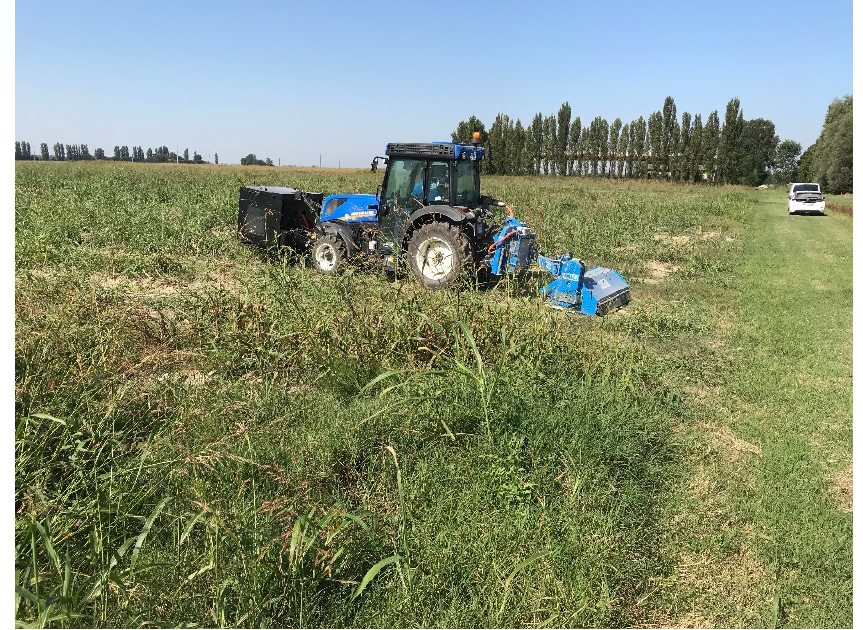
Figure 9. Field with old corn residuals and tall grass to simulate a vineyard interrow (SimVin) during the eMulcher test.